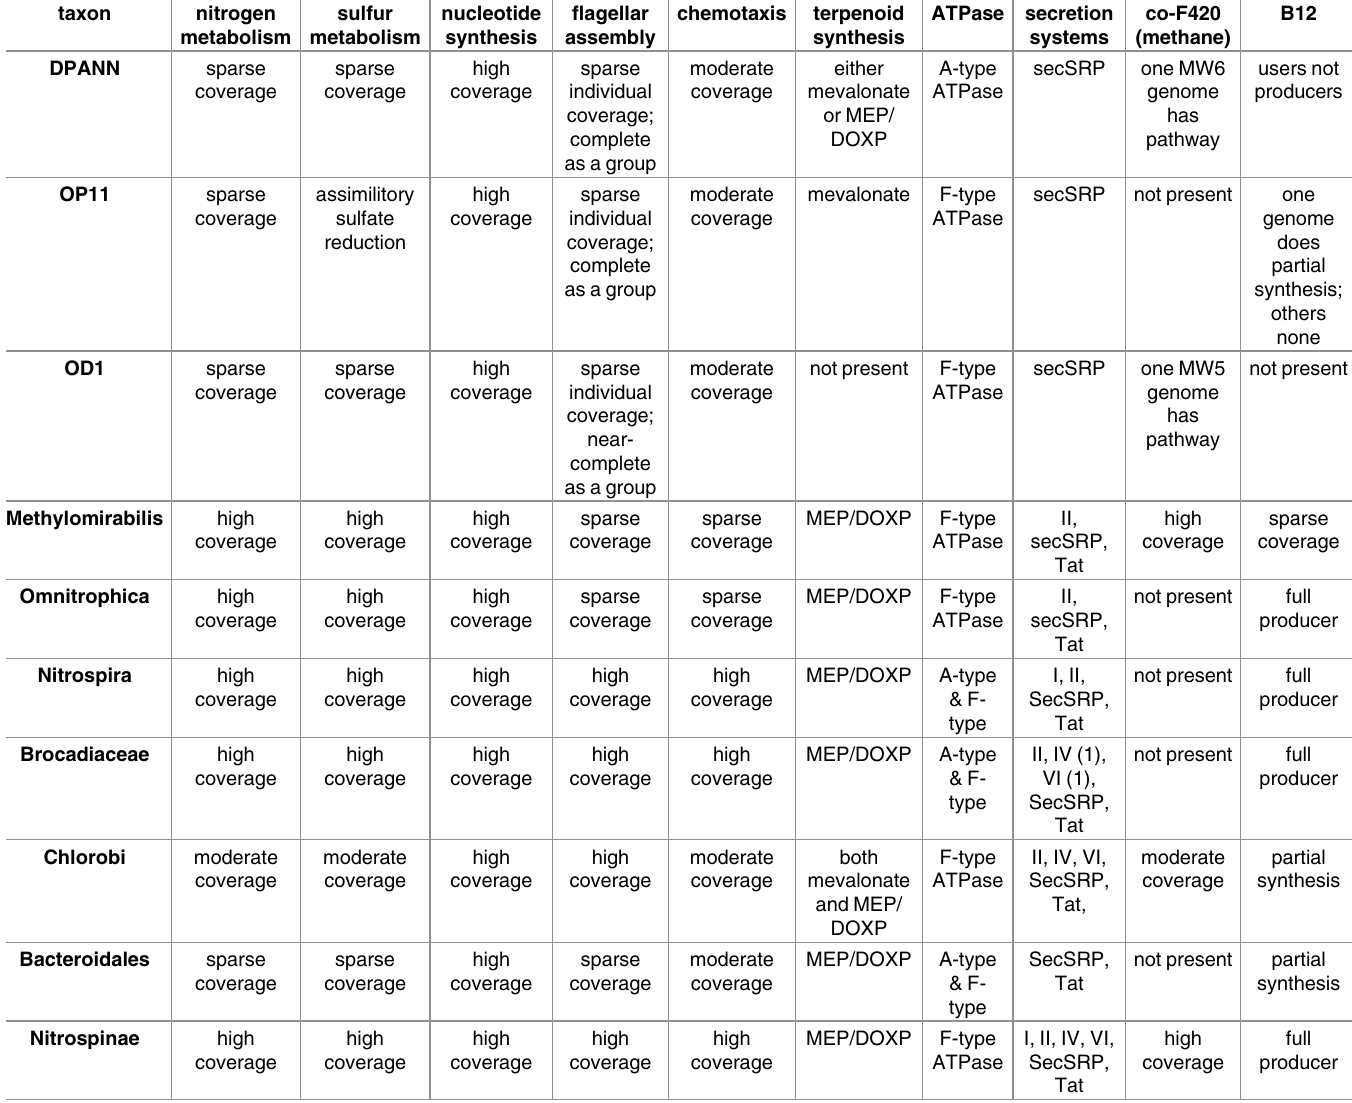
Table 5. Summaryof KEGG pathway representation by phylogenetic grouping. See S13 Table